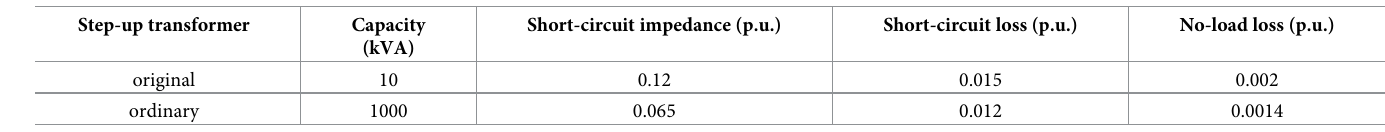
Table 9. Parameters of the two step-up